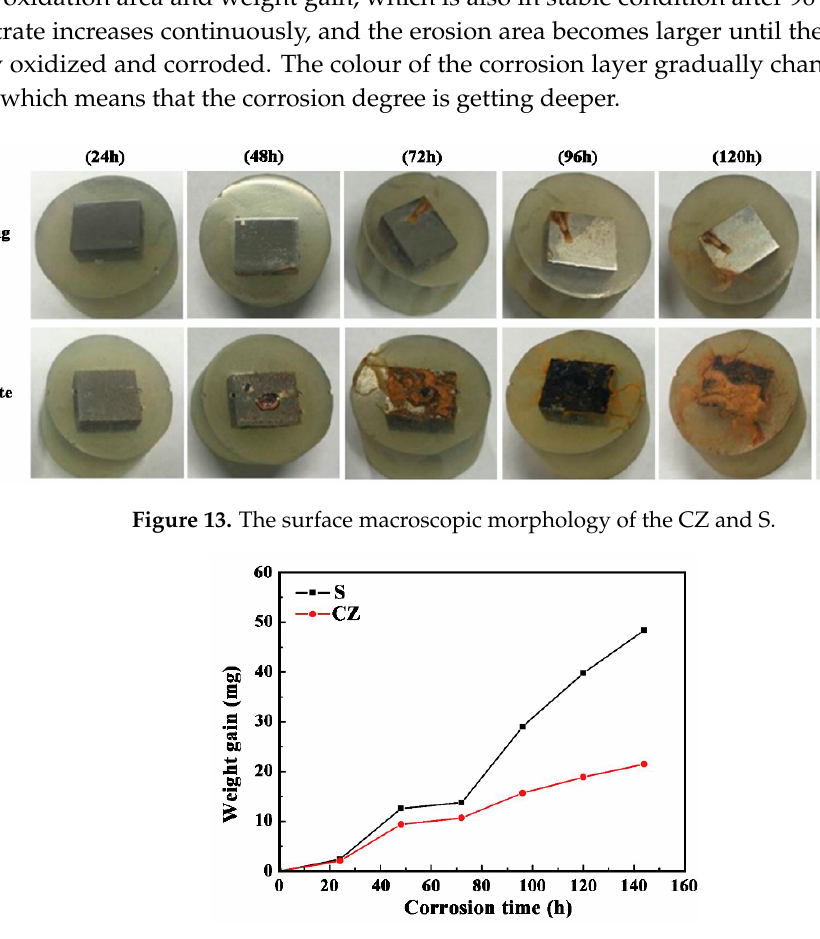
Figure 14. The weight gain comparison of CZ and S.